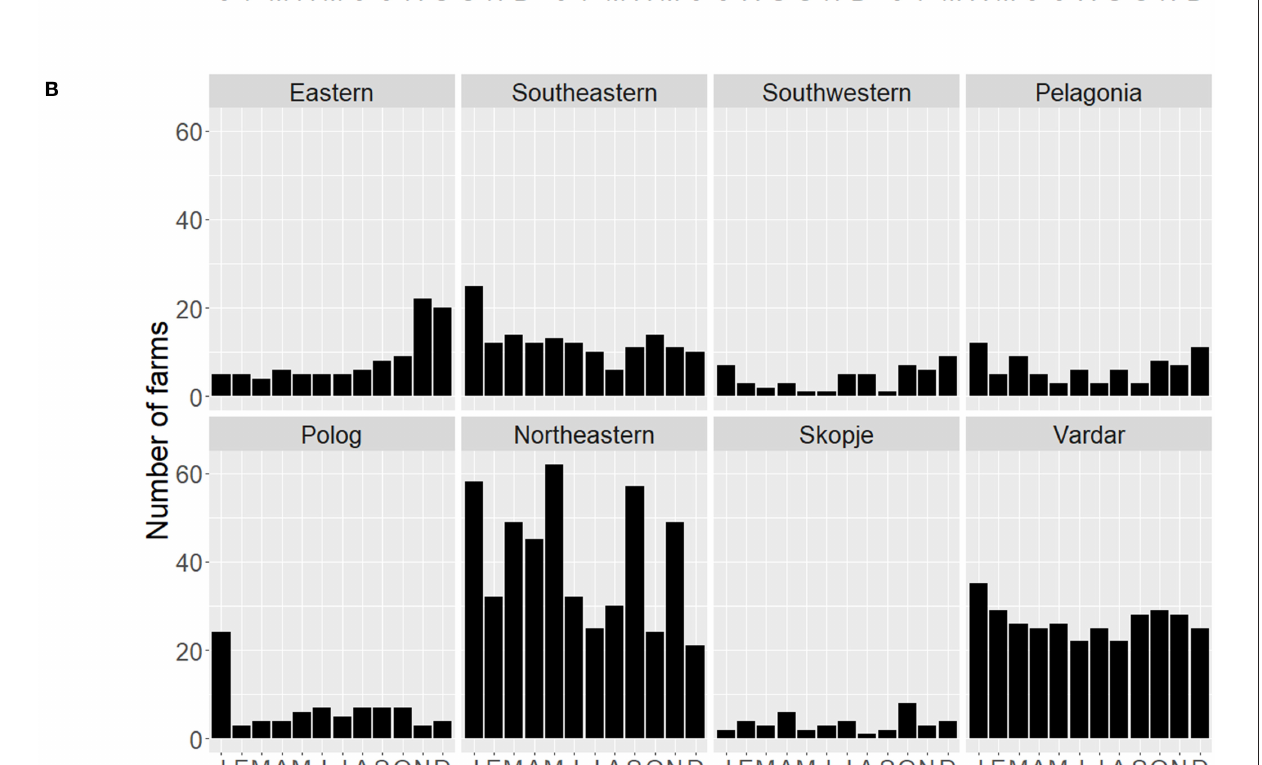
Frontiers in Veterinary Science |